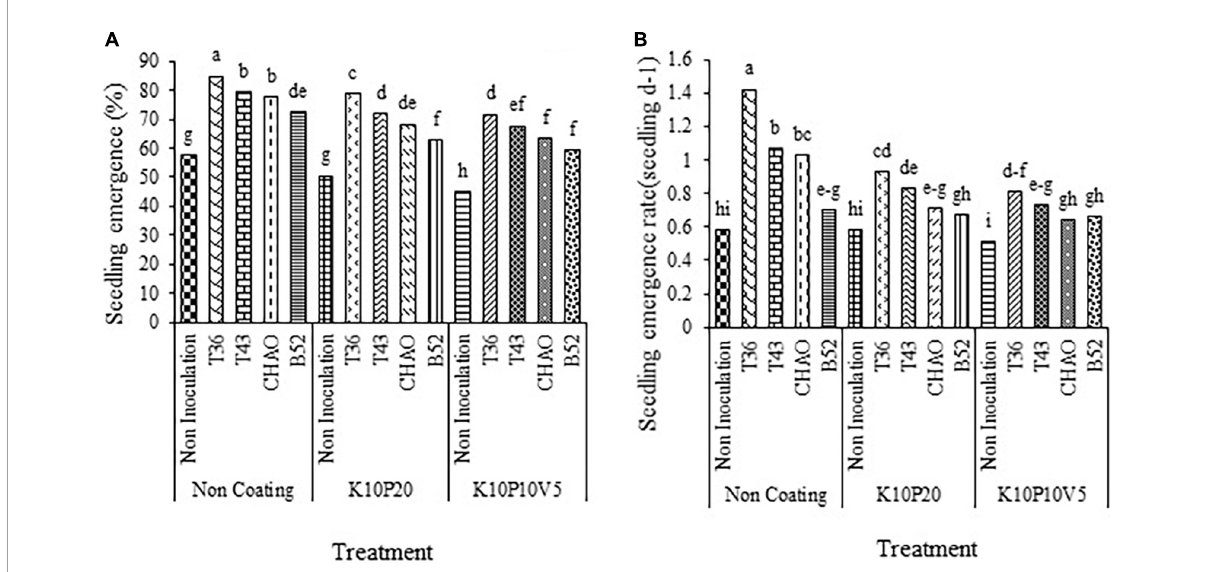
FIGURE5 Interaction of (A) seedling emergence percentage and (B) seedling emergence rate (seedling d - 1 ) of anise affected by inoculation + coating treatments. Means with the same letter are not significantly different according to the HSD test at P = 0.05. CHA0, B52 of Pseudomonas fluorescens , T36 and T43 of Trichoderma harzianum isolates. K, kaolin; V, vermiculite; P, perlite.